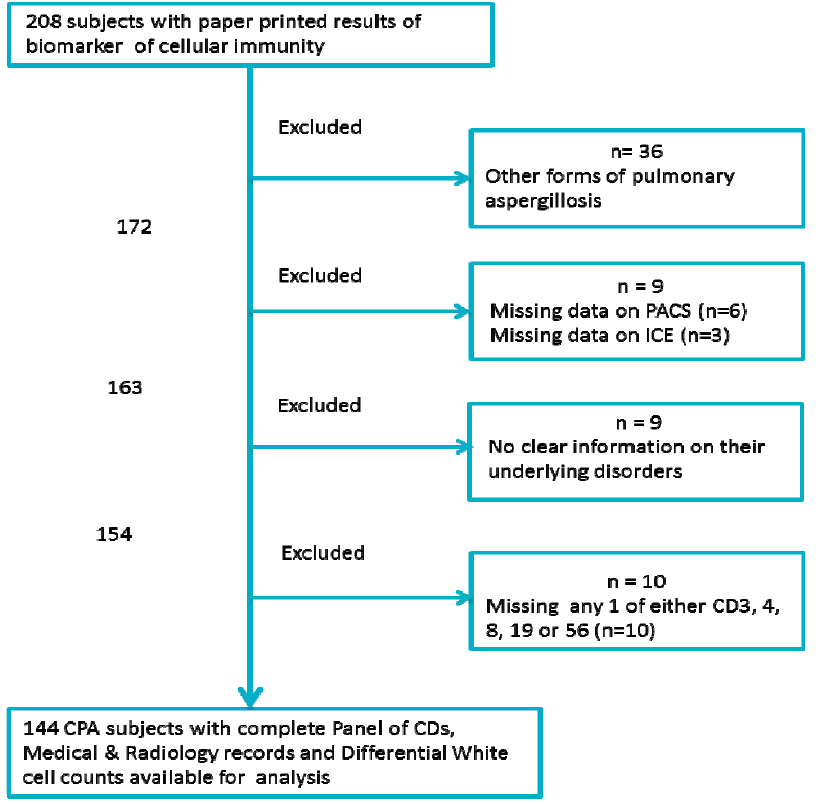
Figure 1. A flow chart showing the selection criteria for the 144 patients. ICE: Integrated Clinical Environment, PACS: Picture archiving and communication system, CD: Cluster of differentiation.